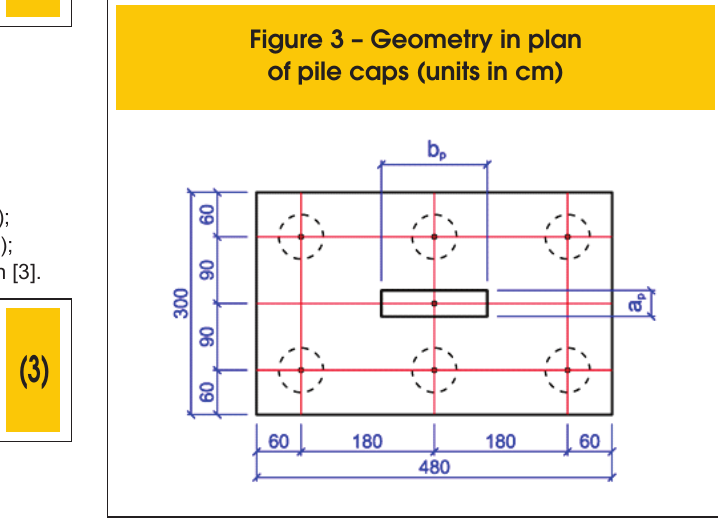
Figure 3 – Geometry in plan of pile caps (units in